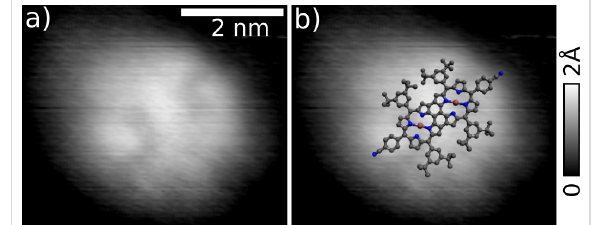
Figure 7: a) High resolution topography image of a single diporphyrin on KBr(001) at room temperature. b) Same image with added molec- ular model. Parameters: f 2nd = 1.02 MHz, A 2nd = 400 pm, Δ f 2nd = − 70 Hz.